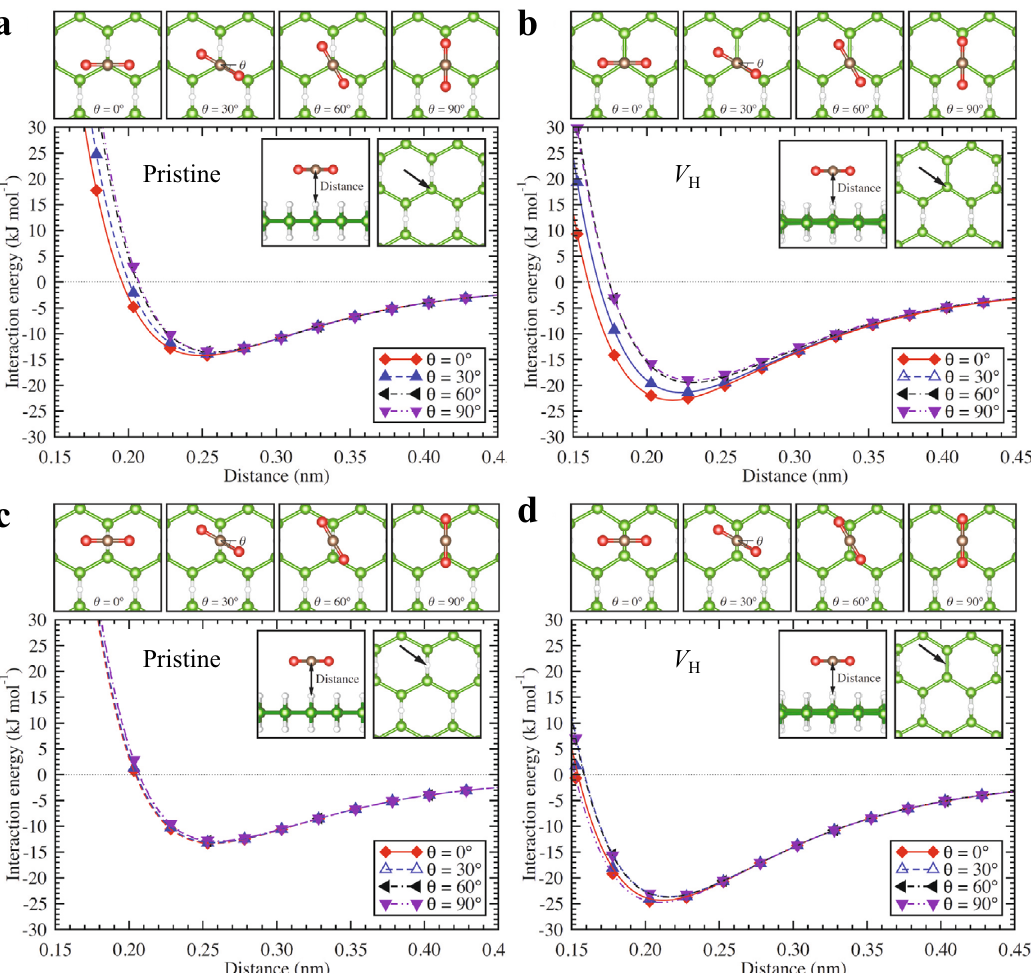
Fig. 3 Adsorption con fi gurations and corresponding interaction energy ( E int ) curves for CO 2 adsorption on hydrogen boride (HB) sheets with the side- on con fi guration. a E int for the on-top B atom sites of the pristine HB sheet. b E int for the on-top B atom sites of the H-vacant ( V H ) HB sheet. c E int for the on-top H sites of the pristine HB sheet. d E int for the H-vacant sites of the H-vacant HB sheet. The distances are de fi ned by the difference between the z - coordinate of CO 2 and the average z -coordinate of the surface H atoms of the HB sheets, as indicated in the inset fi gures. The adsorption sites are indicated by the arrows in the